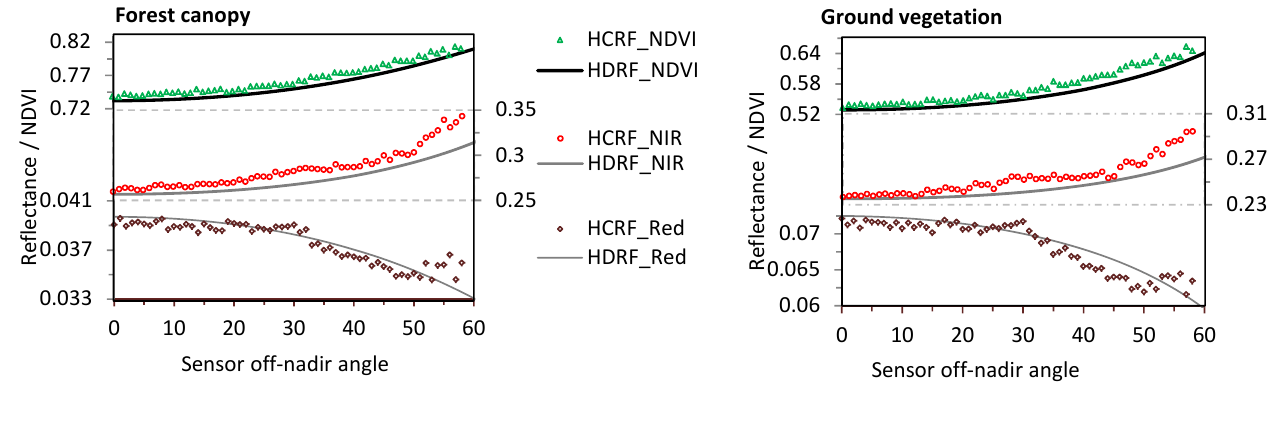
Figure 5. Variation of red and NIR mean reflectance (HCRF) and NDVI with sensor off-nadir angle, in comparison with HDRF values from the FRT model along 270° azimuth. The left graph shows the Abisko forest canopy reflectance and the right graph shows the reflectance from the ground vegetation of the same stand. The HCRF results are computed by using Monte-Carlo integration and the FRT